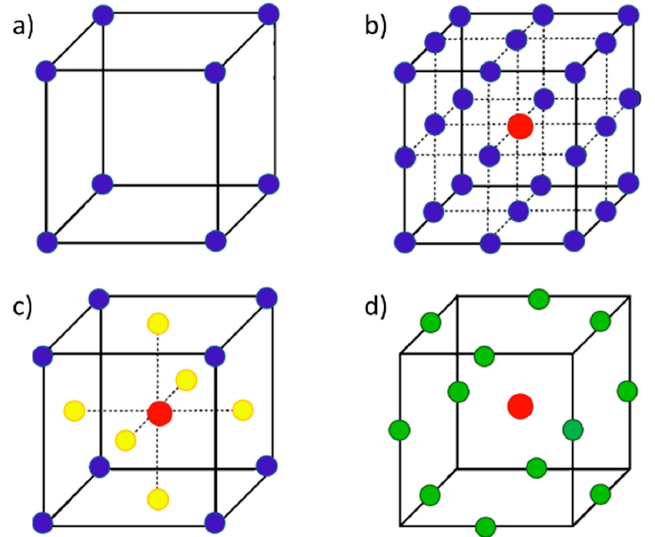
Figure 2. Three ‐ factor response surface designs: ( a ) Two ‐ level full factorial, ( b ) Three ‐ level full factorial, ( c ) Face ‐ Centered Central Composite, and ( d ) Box–Behnken designs. Blue dots: factorial, red dots: center, green dots: edge, yellow dots: axial (star).